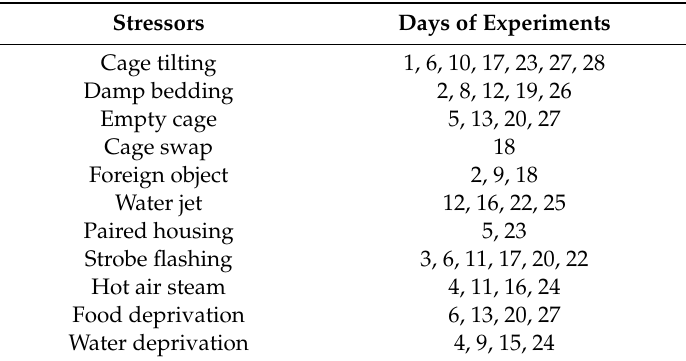
Table 1. Chronic mild stress